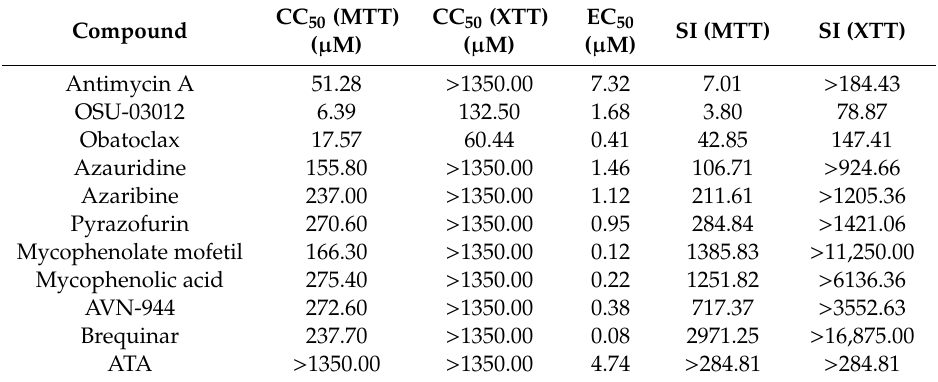
Table 5. CC 50 , EC 50 and SI of the compounds against new World ZIKV PRVABC59 strain.